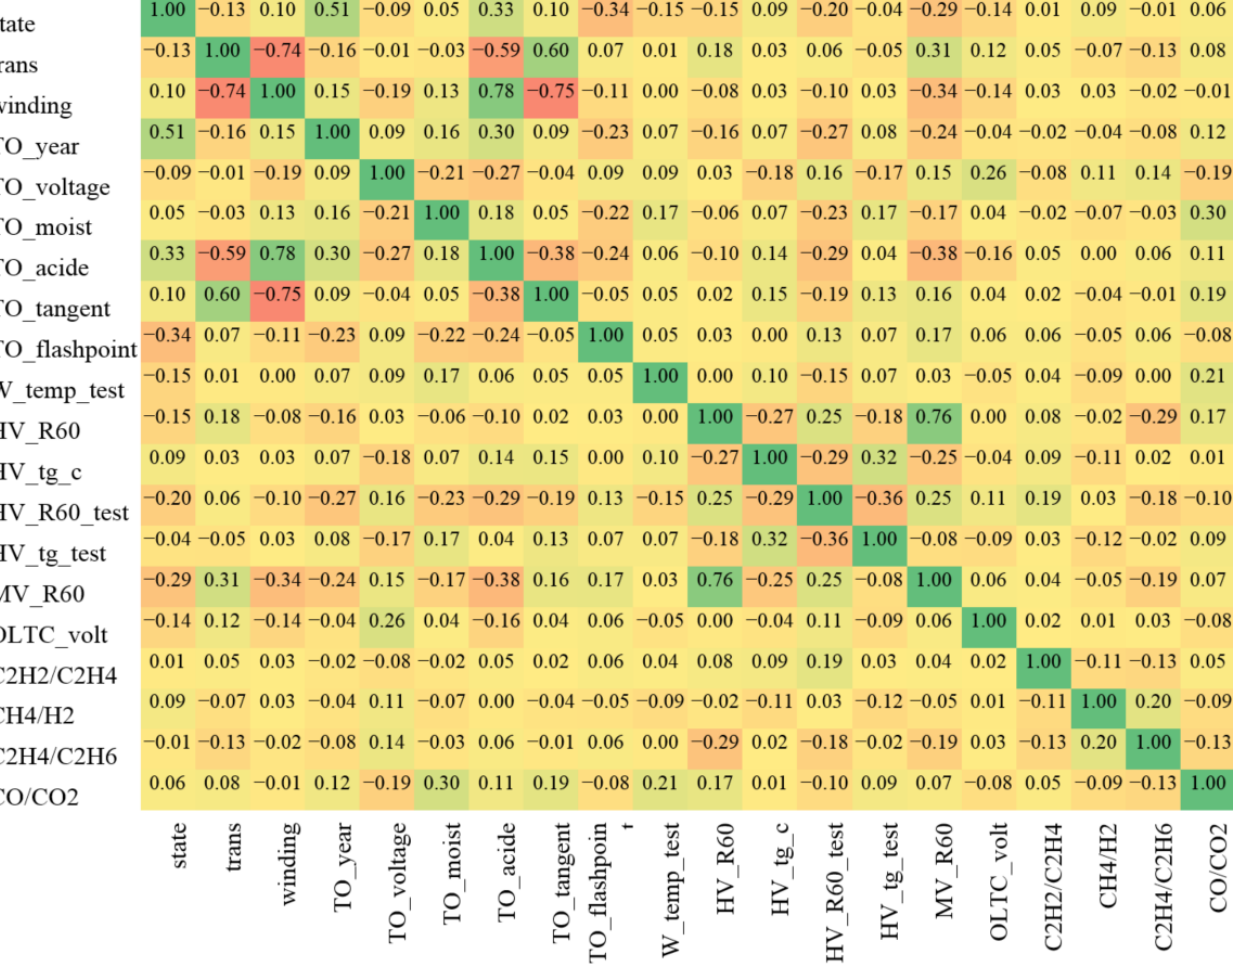
Figure 14. Spearman correlation matrix of the